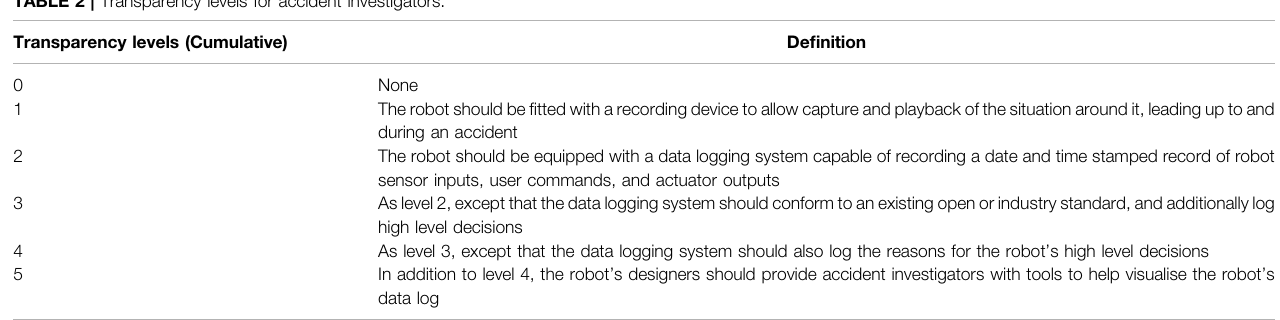
TABLE 2 | Transparency levels for accident investigators. Transparency levels